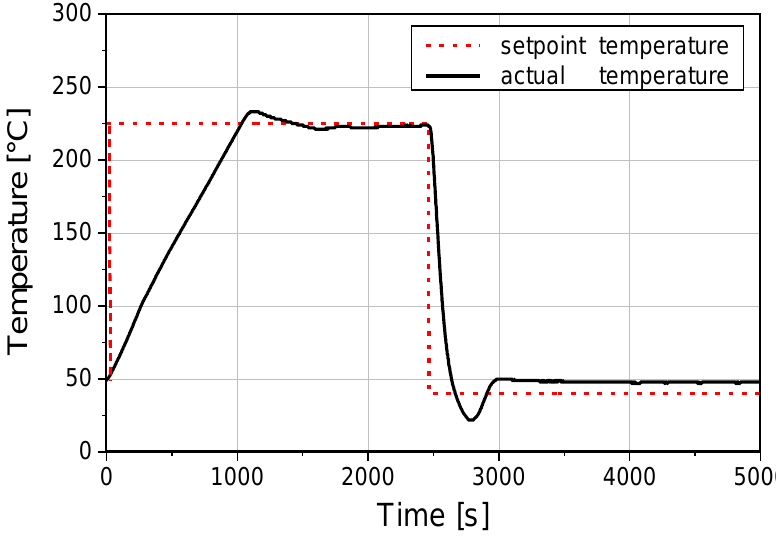
Figure 2. Set heating rate and the resulting actual temperature of the compression moulding process.